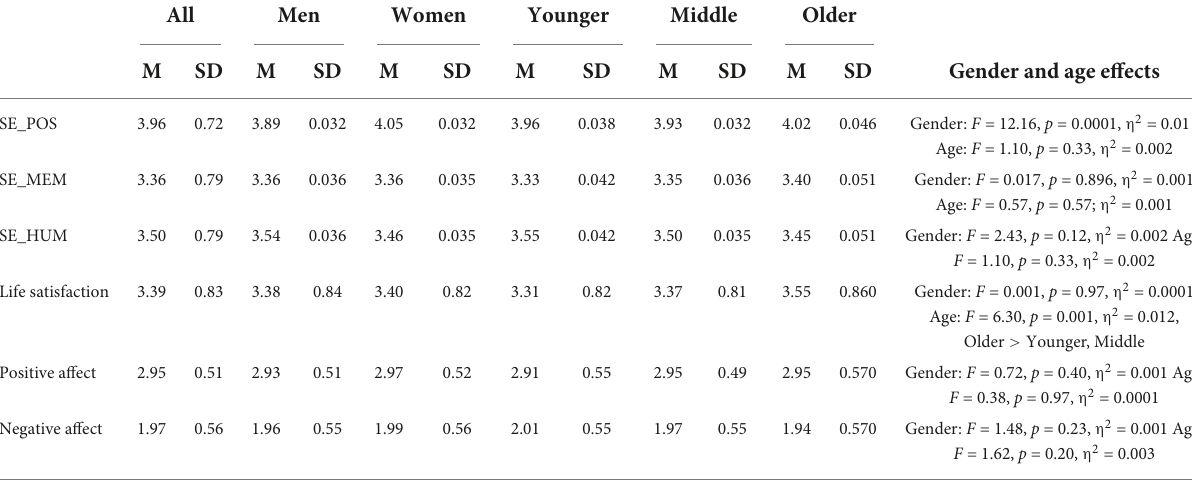
TABLE 3 Gender and age differences in the dimensions of self-efficacy for the management of positive emotions and for indicators of wellbeing. All Men Women Younger Middle Older